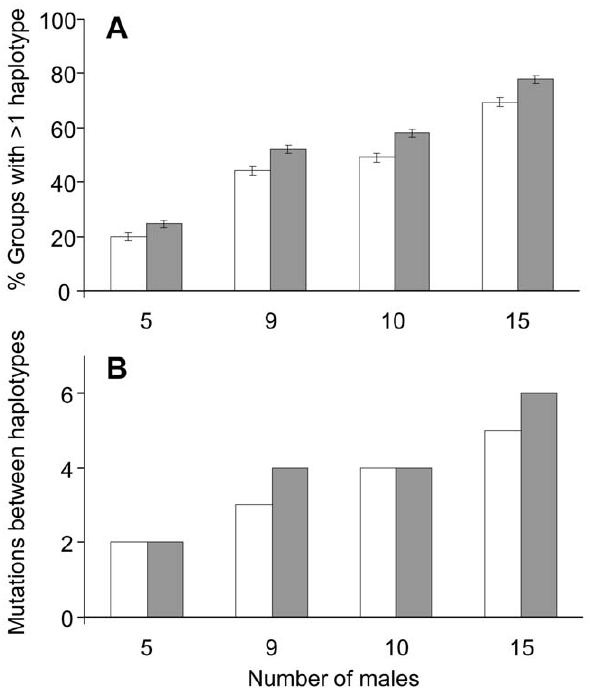
Figure 2. Simulations of Y–chromosomal variation in social groups of western chimpanzees and bonobos. Using empirically– based levels of reproductive skew, mutation rates and group sizes, we examined levels of haplotype diversity in terms of (A), number of haplotypes and (B), maximum number of mutational steps between Y– haplotypes that might arise within groups in the absence male– mediated gene flow. (A), the proportion of groups with more than one Y–haplotype and (B), the simulated maximum number of mutations possible between Y–haplotypes within groups increases with the number of males in the group. White bars indicate bonobos, grey bars indicate chimpanzees. Maximum numbers of mutations are only shown if observed in . 1% of simulated groups. Average number of reproducing males in the habituated study groups =9. Error bars represent 6 one standard deviation.